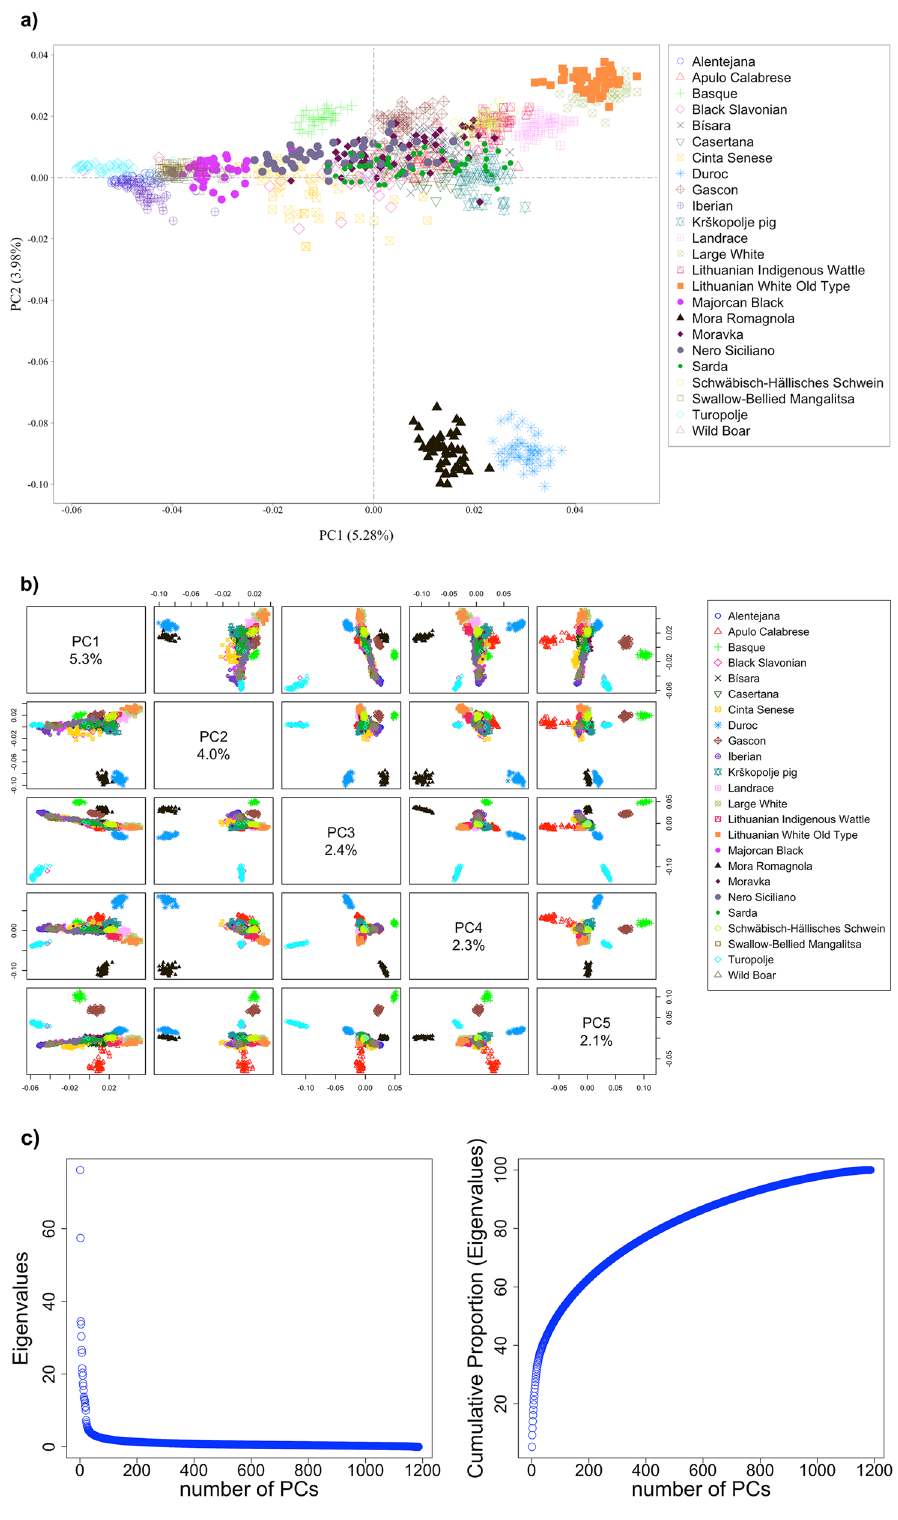
Figure 1. Results of the principal component analysis using the genotypes of 1,186 pigs: ( a ) Scatterplot of the first two principal components (PCs), ( b ) pairwise scatterplots of the first five PCs and ( c ) variance and cumulative variance explained by the